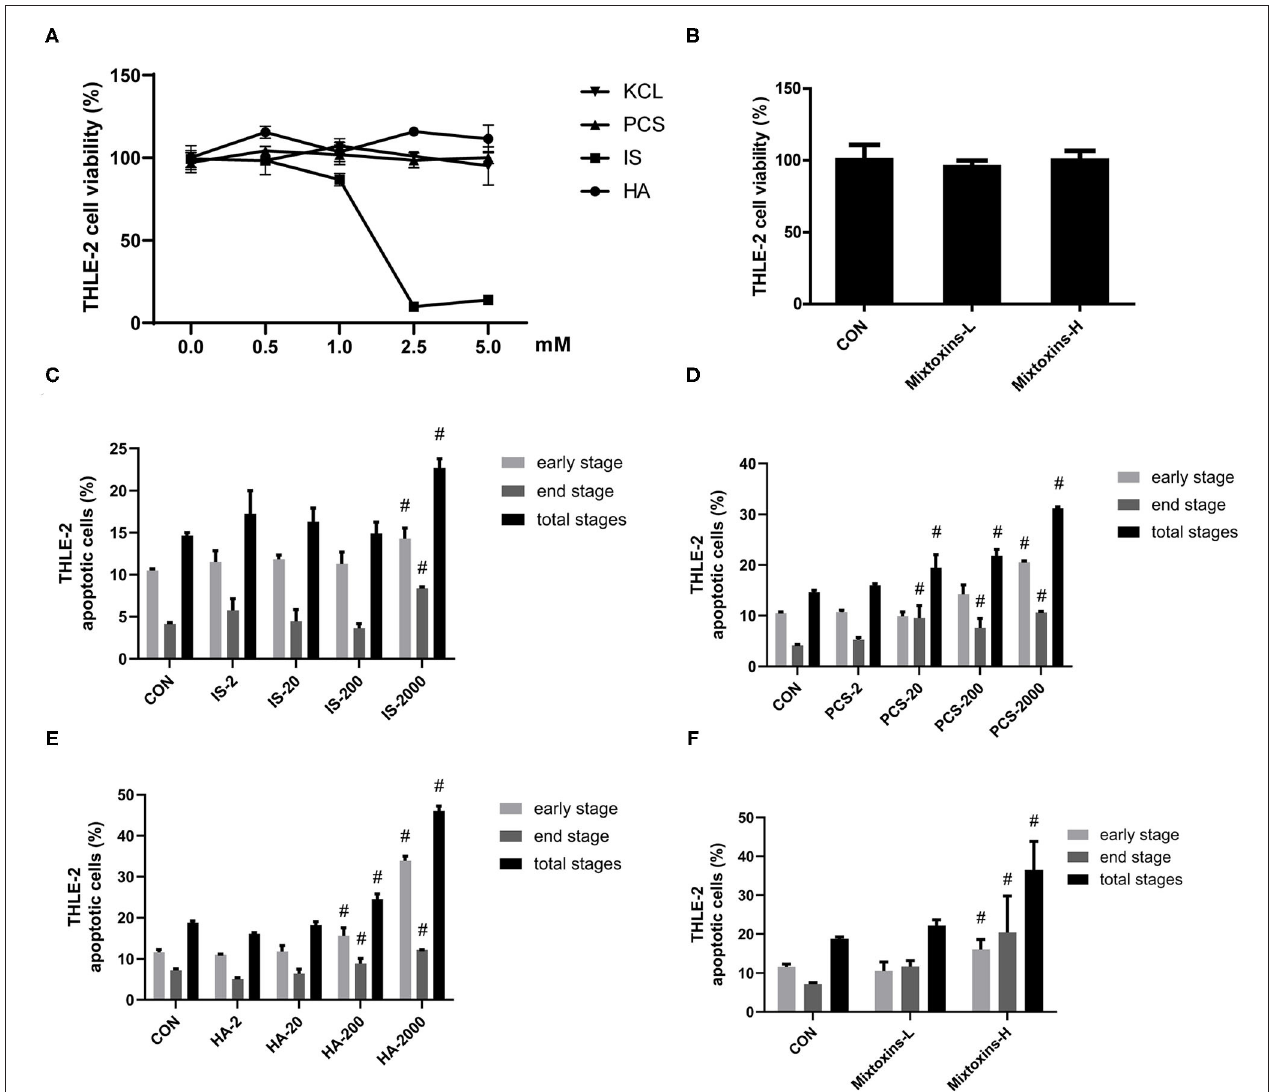
FIGURE 2 | Gut-derived PBUTs induced apoptosis in THLE-2 cells. (A) PBUTs cytotoxic effects. CCK8 assay was performed for THLE-2 cells treated with PCS, IS, HA, and KCL at doses of 0-5mM for 24h ( n = 3). (B) Effects of three PBUTs mixture on THLE-2 cell viability ( n = 5). (C) Effect of IS on THLE-2 apoptosis ( n = 2-3). After 24h treatment, flow cytometry was performed on cells stained with annexin V-FITC and PI. CON, control. IS-2, 2 µ M IS treatment. IS-20, 20 µ M IS treatment. IS-200, 200 µ M IS treatment. IS-2000, 2000 µ M IS treatment. Group settings are the same with PCS (D) and HA (E) . (D) Effect of PCS on THLE-2 apoptosis ( n = 2-3). (E) Effect of HA on THLE-2 apoptosis ( n = 3). (F) Effects of three gut-derived PBUTs mixture on THLE-2 apoptosis ( n = 3). For all bar graphs, the data are the mean ± SD. #, P < 0. 05 vs. CON group. The significant difference was assessed using the one-way ANOVA followed by LSD